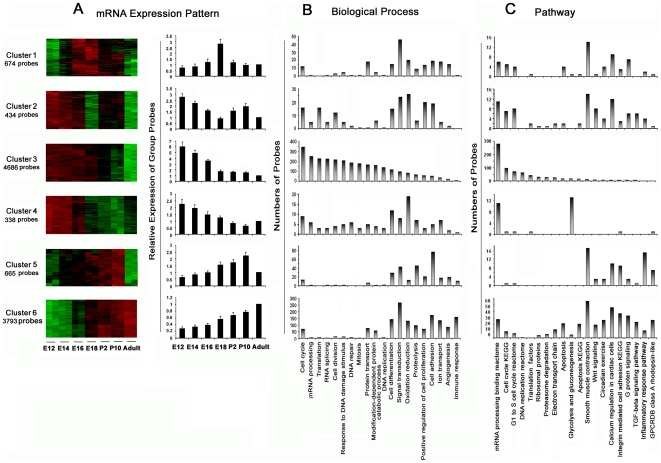
Temporal expression patterns of mRNA using hierarchical cluster analysis and biological functional patterns by GO biological process and pathway analysis.(A) 6 temporal expression patterns represented by color heat maps and bar graphs (x axis indicating the 7 time points, y axis indicating the relative expression value of group probes). The relative expression values in each time point are the ratios normalized against those in the adult group. (B) Biological process patterns of 6 expression clusters represented by bar graphs (x axis indicating top 20 GO terms on biological process, y axis indicating the number of probes) (C) Pathway patterns of 6 expression clusters represented by bar graphs (x axis indicating top 20 GenMAPP pathway annotations, y axis indicating the number of probes).